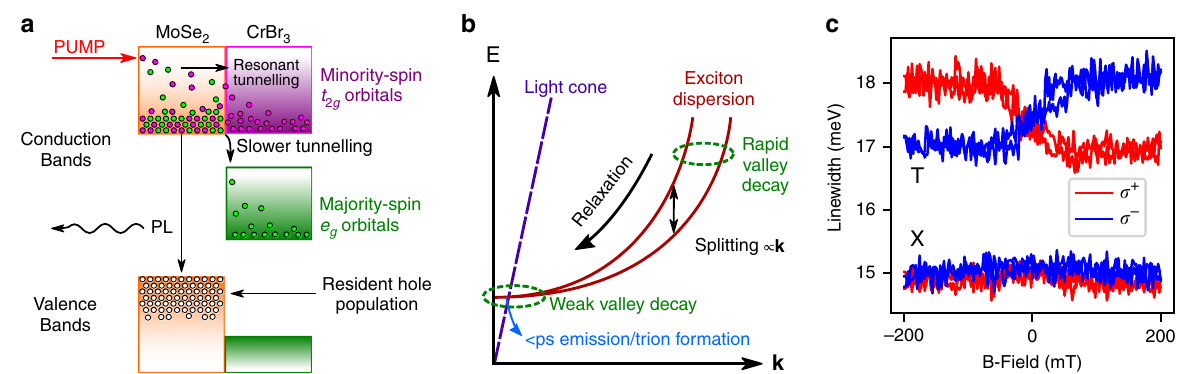
Fig. 3 Spin-dependent interlayer tunneling. a Schematic of spin-dependent interlayer charge transfer over the MoSe 2 /CrBr 3 interface. The type-II band alignment precludes a static electron doping in MoSe 2 , and so we infer a resident hole population. In CrBr 3 , the CB is strongly split into oppositely spin- polarized bands. Only the minority-spin bands are resonant with the MoSe 2 CB. Upon optical injection of electron-hole pairs, the electrons may tunnel from MoSe 2 to CrBr 3 , with ef fi ciency depending on their spin (green or purple indicate opposite spin). As CrBr 3 is transparent at our laser energy, absorption is negligible, and so we expect no appreciable dynamic hole transfer from CrBr 3 to MoSe 2 . b Diagram of exciton dispersion in MoSe 2 , with an energy splitting (the L-T splitting, see main text) proportional to in-plane wavevector k . The L-T splitting acts as an effective magnetic fi eld inducing valley pseudospin relaxation in the presence of disorder scattering. Outside the light cone, ef fi cient valley depolarization prevents spin-dependent tunneling from in fl uencing the eventual DOCP. At low k , the spin-dependent tunneling is able to in fl uence the DOCP observed in PL. At vanishing center of mass momentum, the exciton population either radiatively recombines (sub-ps) or else binds to a resident hole to form a long-lived trion valley state, which will be susceptible to spin-dependent tunneling. c Polarization resolved PL linewidths of the exciton (X) and trion (T). The trion linewidth shows opposing behavior in different polarizations, indicating that the lifetime is in fl uenced by spin-dependent interlayer tunneling. The exciton has a constant linewidth, indicating insensitivity to CrBr 3